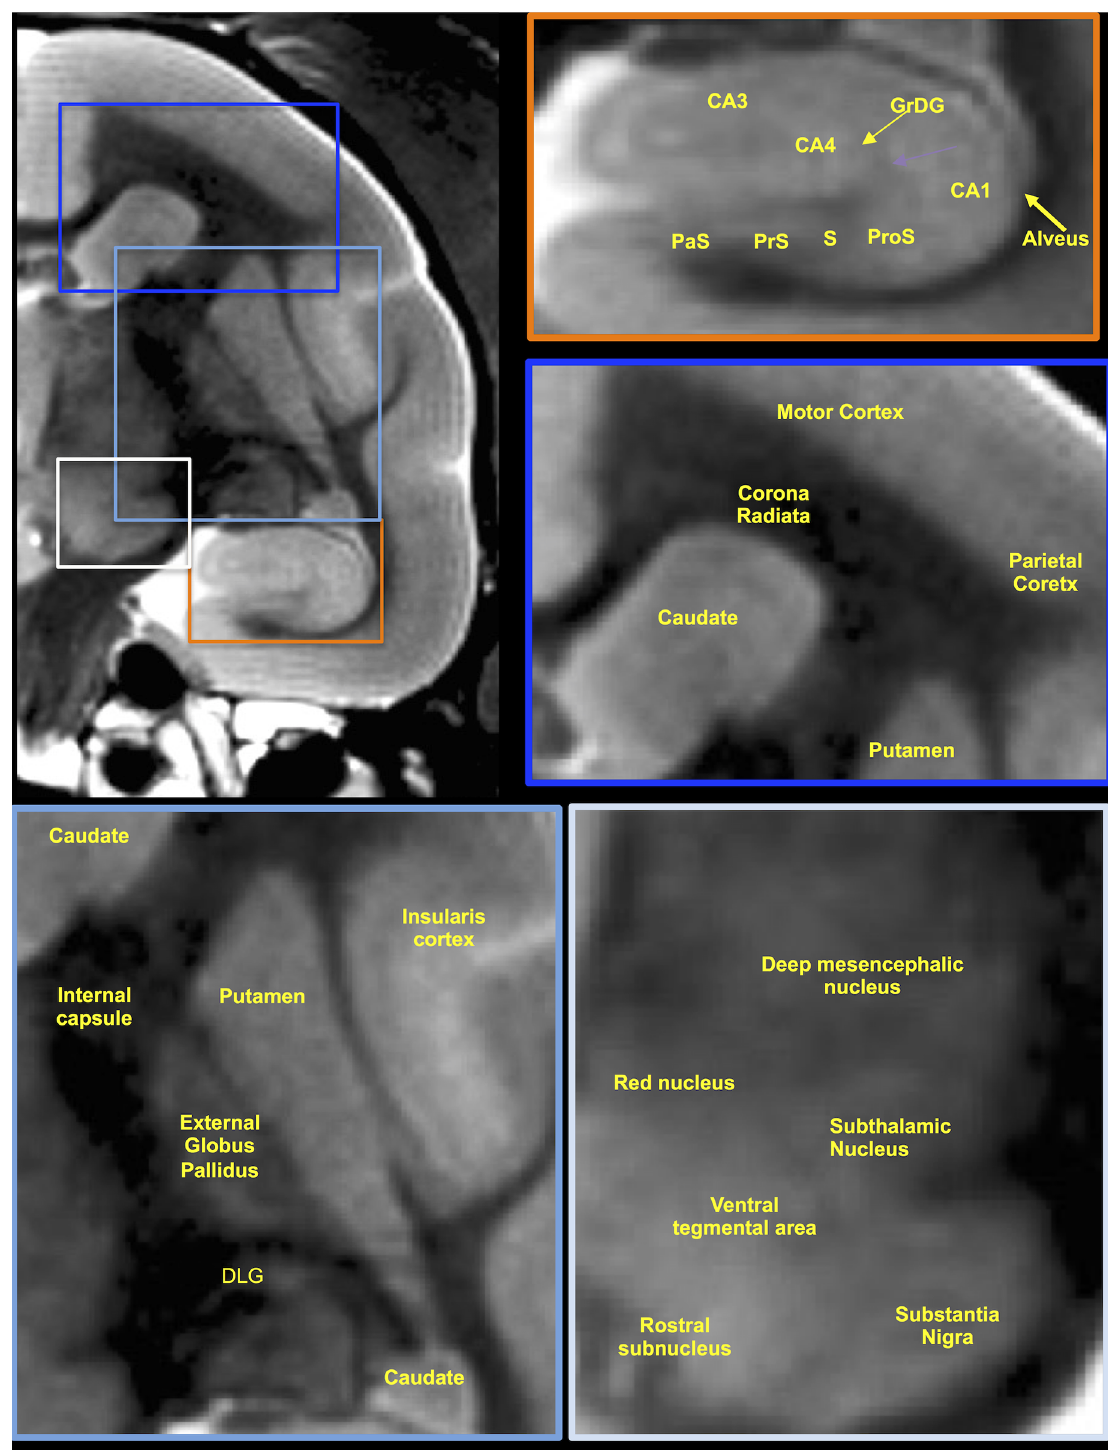
Fig 1. Delineation and distinction of anatomical structureson T 2 -weighted MR images. The high spatialresolutionused here (0.0875 mm 3 /voxel) afforded the clear delineationof anatomical regionsin the midbrain,such as the deep mesencephalic nucleus,red nucleus,ventral tegmentalarea, rostral subnucleus.subthalamic nucleus,as well as the substantianigra. However, the lack of well-defined signal differences betweenthese did not allow separatevolumetricquantification of these. The putamen in contrast could be reliabledelineated against surroundstructures, such as the externalglobus pallidus,the internalcapsule,the